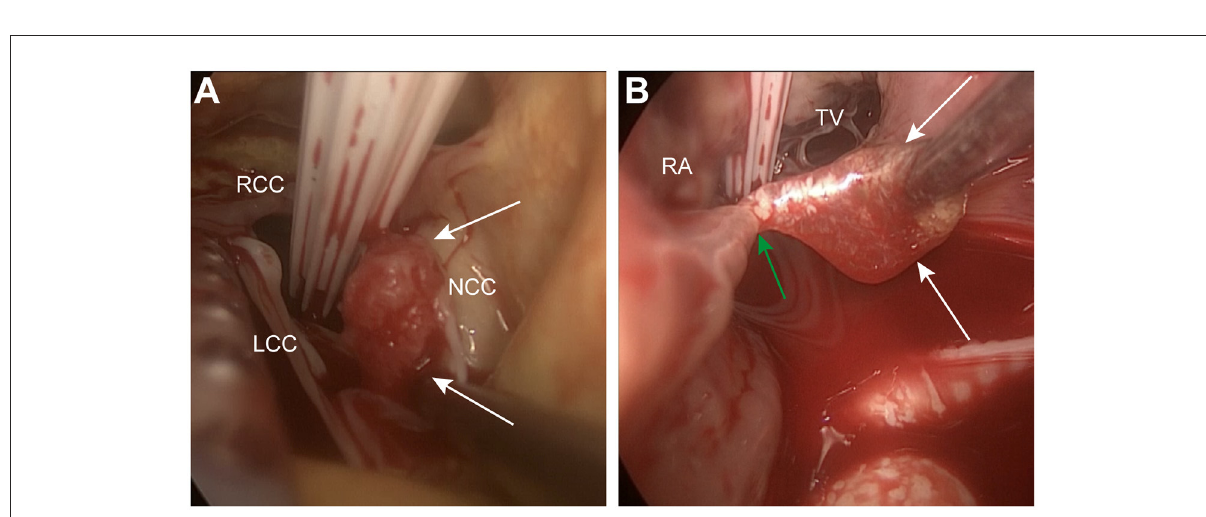
FIGURE2 (A) CPF was located on the ventricular side of non-coronary cusp of aortic valve (white arrows); (B) CPF (white arrows) was located in the RA adjacent to aortic root with a stalk (green arrow). CPF, cardiac papillary fibroelastoma; NCC, non-coronary cusp; RCC, right-coronary cusp; LCC, left-coronary cusp; RA, right atrium; TV, tricuspid